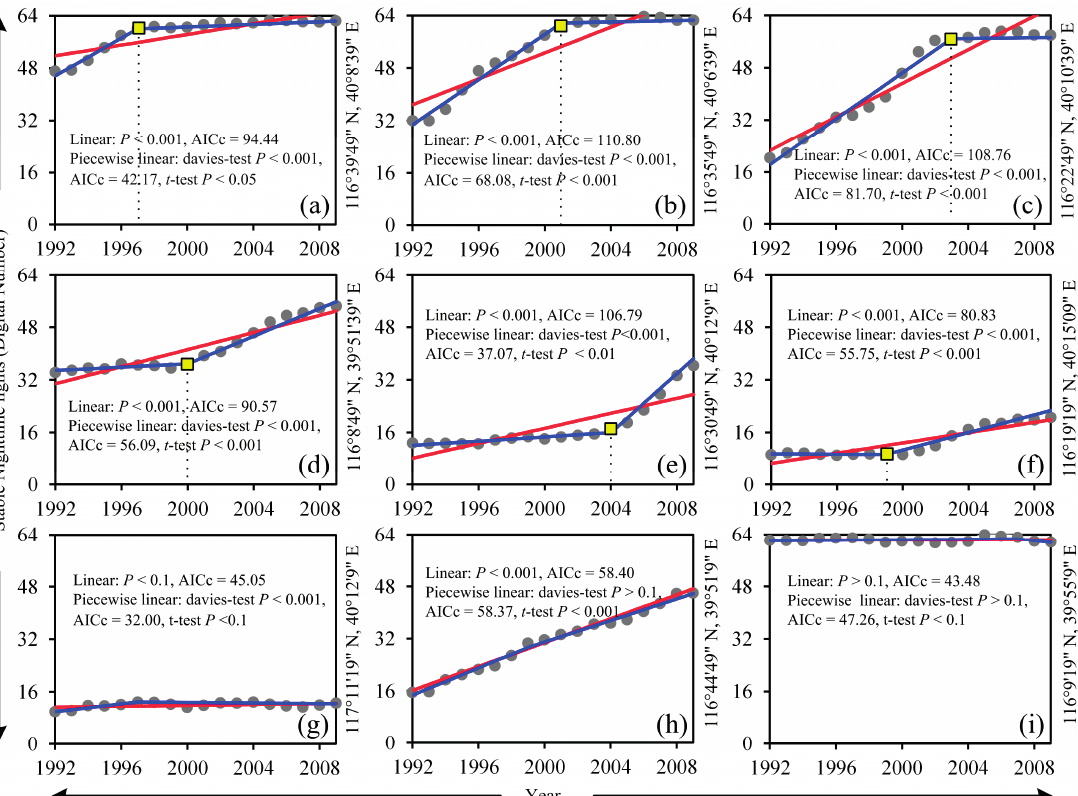
= interception, β = slope. l 0 l 1 = interception, β = left slope, 0 1